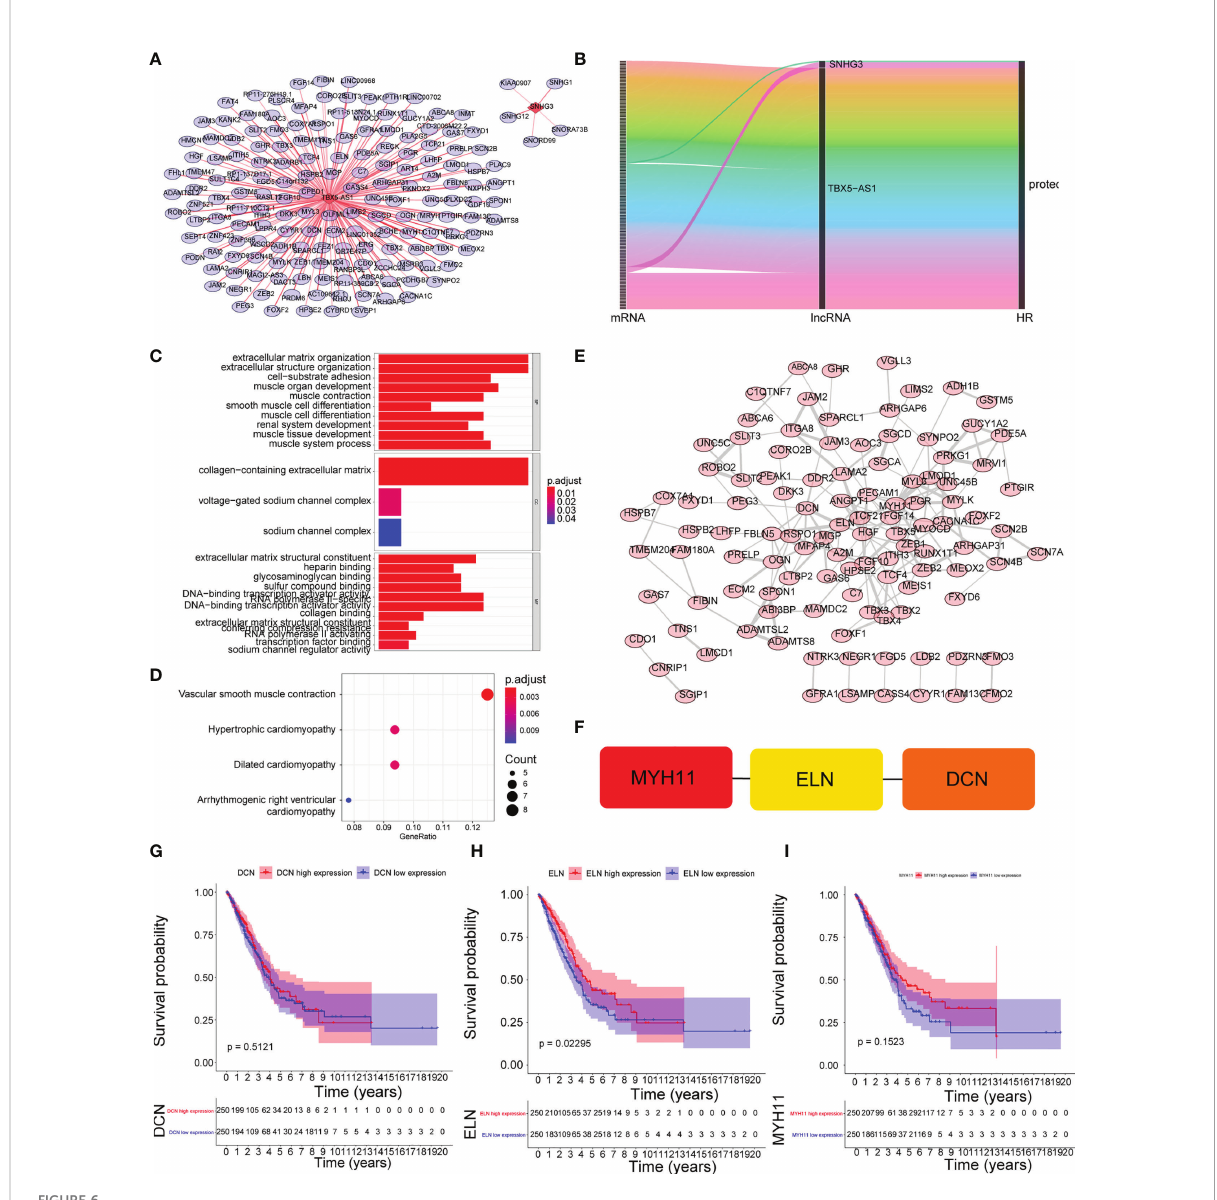
FIGURE 6 Identi fi cation of mRNAs associated with prognostic lncRNAs. (A) The coexpression network between prognostic lncRNAs and mRNA. Red diamond nodes represent prognostic lncRNAs, and the sky blue round nodes represent prognostic-related mRNAs. The coexpression network was visualized using Cytoscape 3.7.2 software. Green circles represent mRNAs that are both associated with prognostic lncRNAs and cis- regulated. (B) Sankey diagram showed the association between prognostic related lncRNAs and mRNAs. (C) GO enrichment analysis. (D) KEGG enrichment analysis. (E) Protein interaction network. (F) identi fi cation of the top3 hub genes. (G – I) K – M survival curve of the expression levels of MYH11, ELN, DCN and the corresponding survival